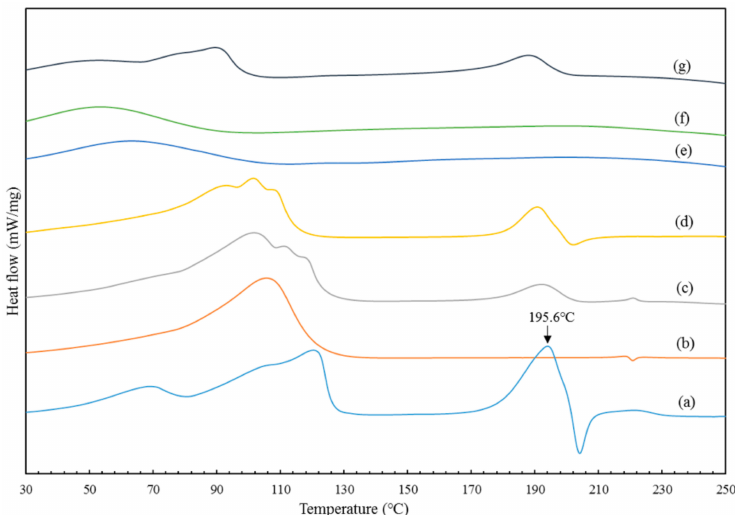
Figure 6. Differential thermal scanning curves of ( a ) BBR; ( b ) raw β -cyclodextrin; ( c ) physical mixture (1:1, n / n ); ( d ) ICB; ( e ) (BP m Sample 7; ( f ) BP n Sample 2; ( g ) BP mix Sample